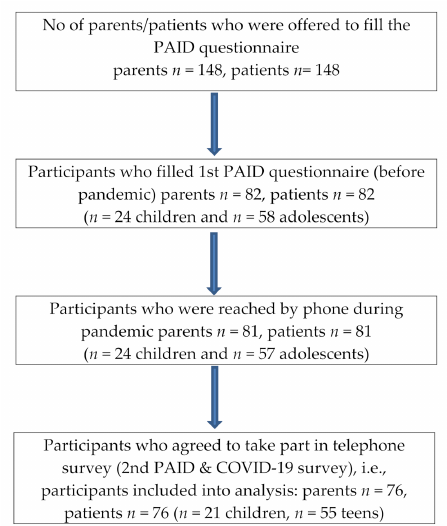
Figure A1. Study flow